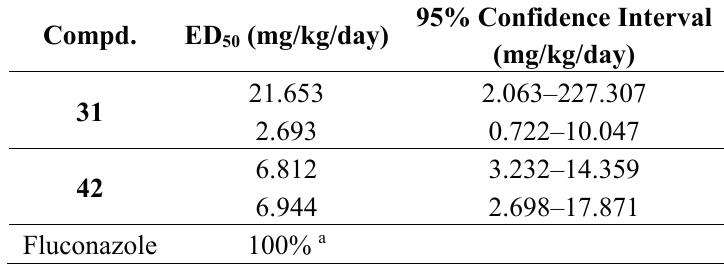
Table 3. The ED 50 (50% effective dose) values and 95% confidence intervals for the compounds.